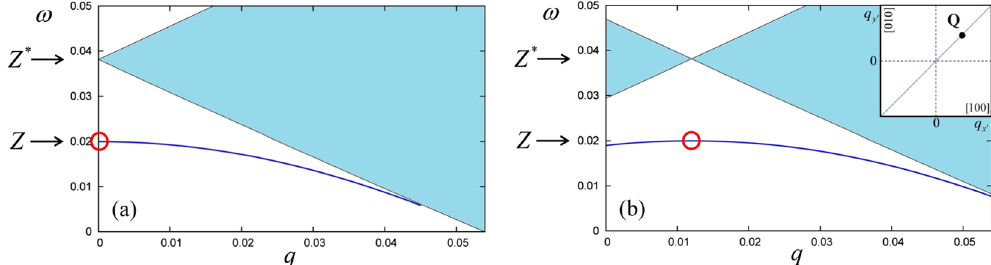
Figure 3. ( a ) Spin-wave dispersion ω sw,0 ( q ) (line) and single-particle spin-flip continuum (shaded area) without SOC. ( b ) Spin-wave dispersion ω sw ( q ) and single-particle spin-flip continuum, plotted along [110], for α = β = 0.003 ( Q = 0.012). The 2DEG parameters are r s = 2, ζ = − 0.0762, Z = 0.02, and Z * = 0.0381 (all values are in atomic units). The inset shows the position of Larmor’s mode in the wave vector plane ( q x ′ , q y ′